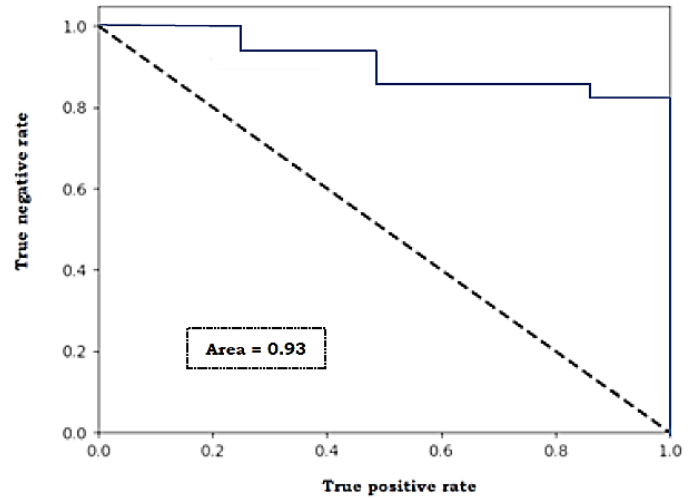
Figure 9. Receiver operating characteristic curve for the proposed model.